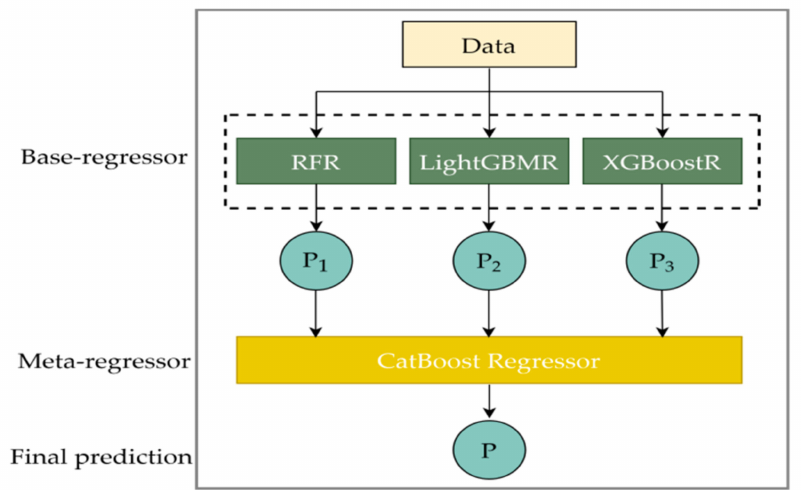
Figure 6. Flow chart depicting the stacking regressor model used for tea polyphenols